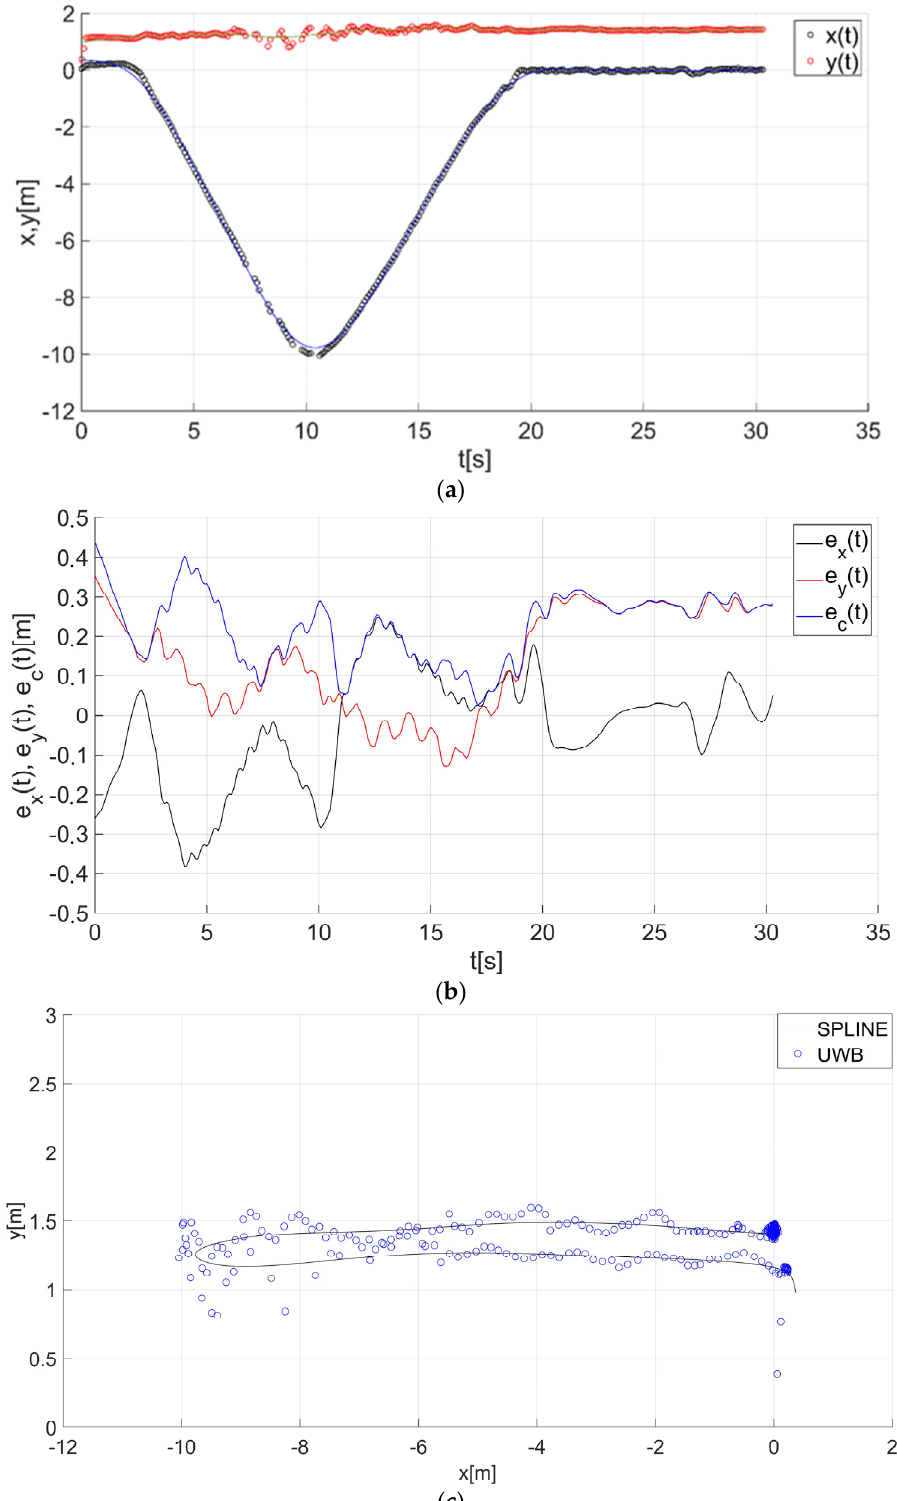
Figure 13. Results for the estimation of guide path no. 1 with the use of the smoothing spline: ( a ) the course of the guide’s location coordinates x(t), y(t) with their continuous estimates, ( b ) the course of the estimated location errors e x (t), e y (t), e c (t), ( c ) guide’s location along with the path estimation [6].